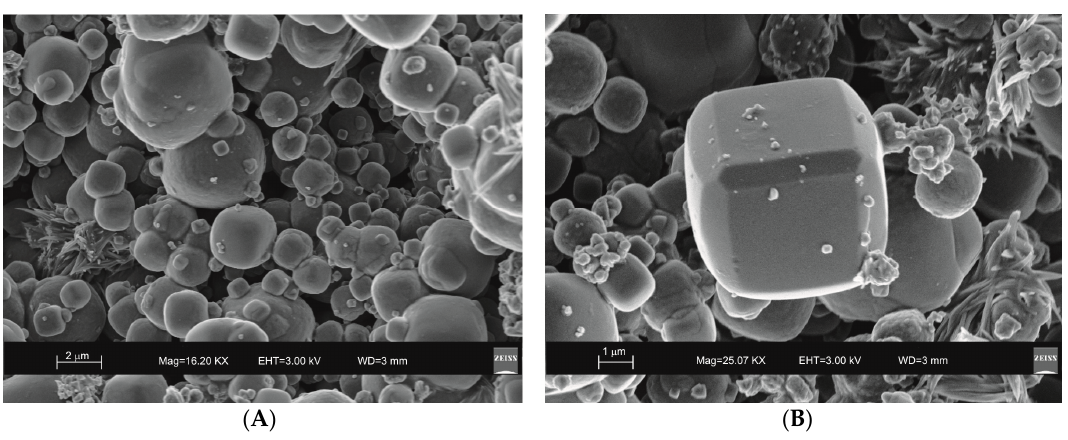
Figure 3. Scanning electron microscopy (SEM) images of LTA zeolite formed through 45 min of hydrothermal process with sonication. ( A ) overview of zeolites formed; ( B ) detail of LTA crystal.